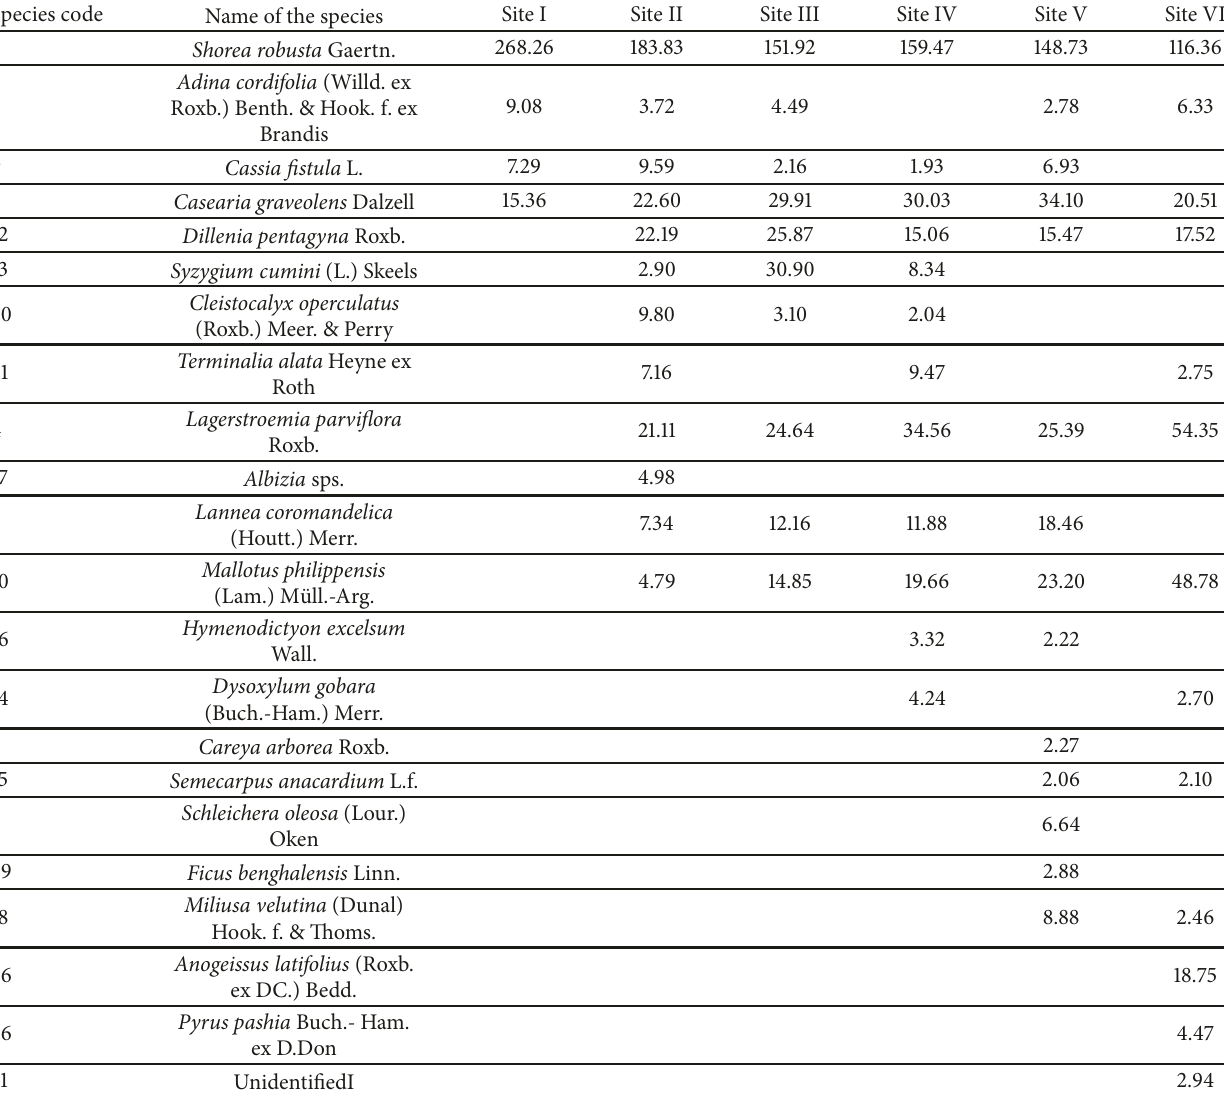
Table 8: IVI of species in Musharni Mai